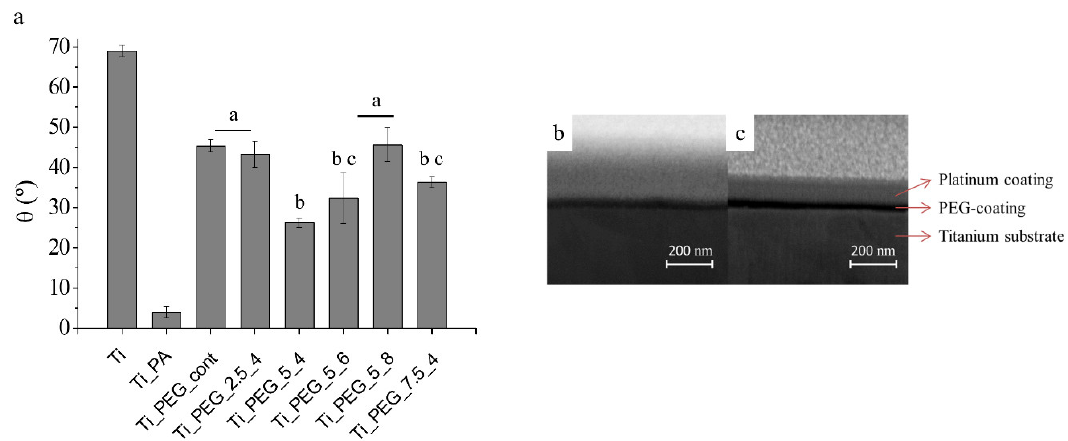
Figure 1. Water contact angle of titanium control and polyethylene glycol (PEG)-coated samples ( a ). Samples with the same symbol have no statistically significant differences ( p < 0.05). Cross sections of Ti_PEG_cont ( b ) and Ti_PEG_5_6 ( c ).